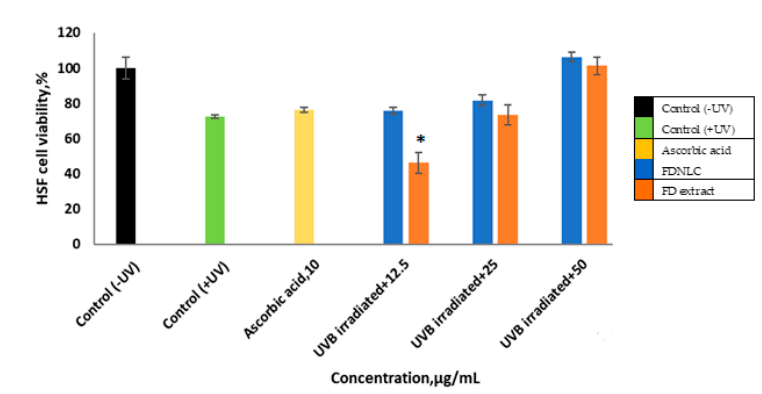
Figure 9. The e ff ect of FDNLC on cell viability of fibroblast cells (HSF 1184) after UVB (ultraviolet B) irradiation (15.0 mJ / cm 2 , 320 nm). Data are presented as mean ± SD ( n = 3). Ascorbic acid, 10—ascorbic acidat10 µ g / mLconcentration. * p <